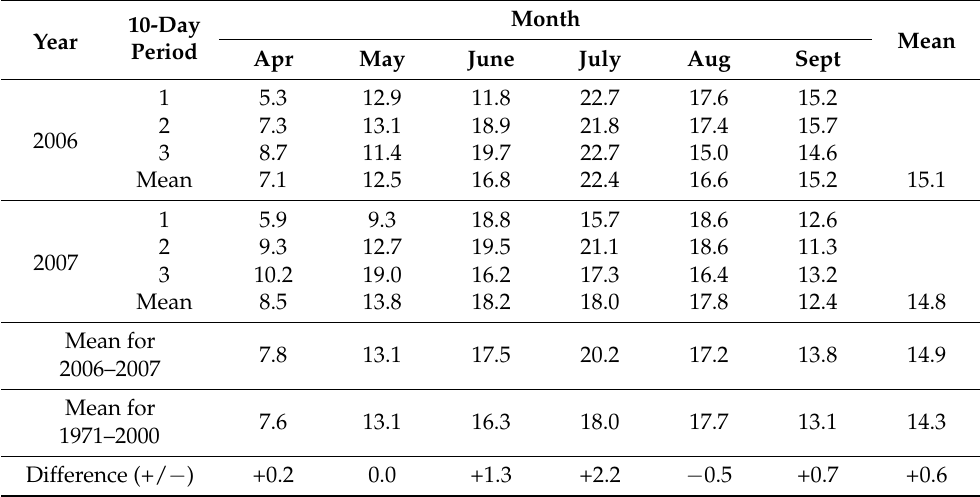
Table 3. Air temperature ( ◦ C) in the 2006–2007 vegetation